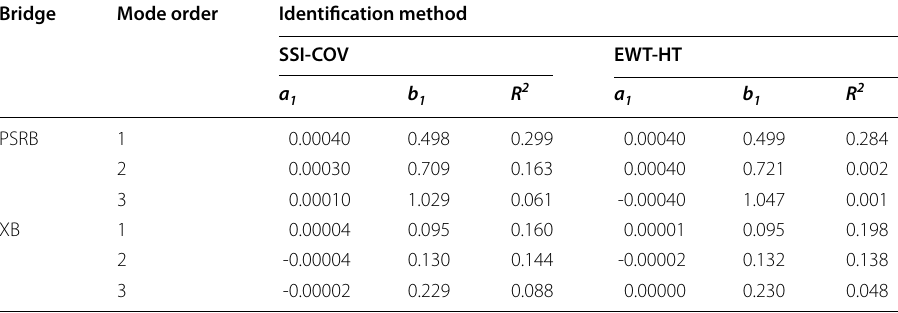
Table 1 Statistics of fitting parameters of identified modal frequencies of PSRB and XB Bridge